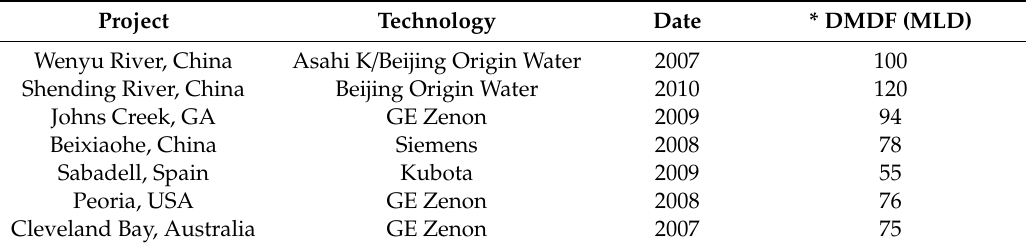
Figure 5. Schematic representation of the principles of the MBR process: ( a ) membrane filtration in MBR and ( b ) membrane fouling in MBR modified and adapted from [3]. Table 2. The largest 8 MBR plants adapted and modified from